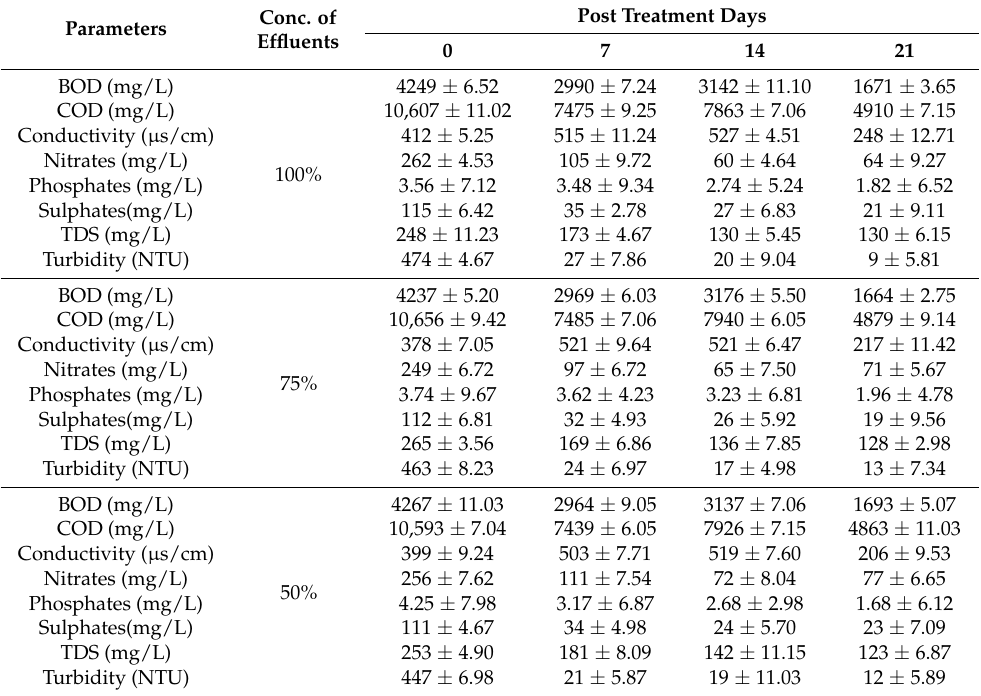
Table 1. The physicochemical features of different concentrations of tannery effluents treated with Saccharomyces cerevisiae .